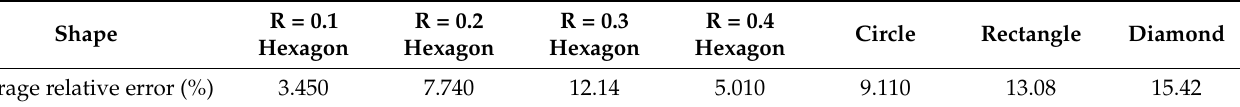
Table 6. Average relative error of predicted drag coefficient after changing